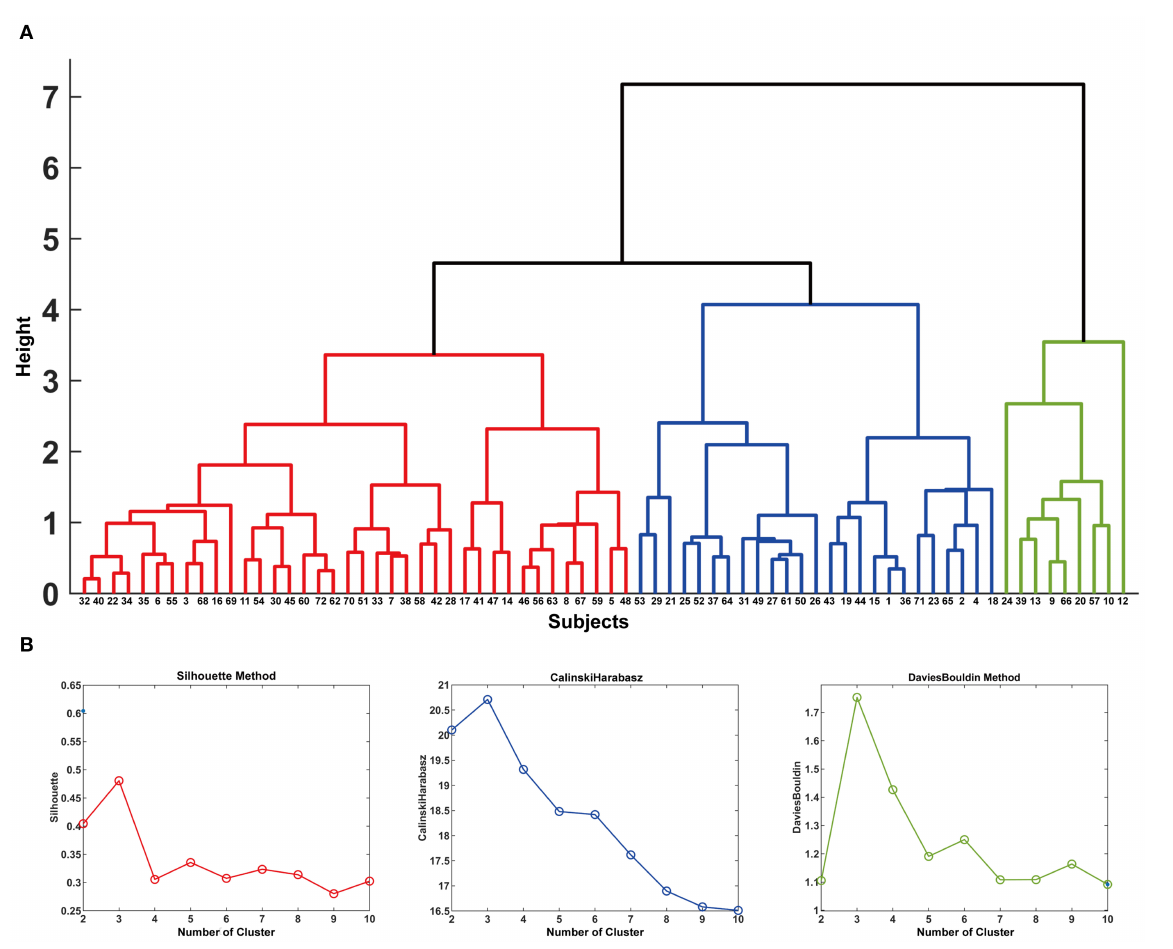
FIGURE4 In (A) , the dendrogram of the hierarchical clustering is illustrated. The y -axis shows the study-specific distances between the clusters as height h. When h = 0, each volume forms its own cluster, and h = 2 corresponds to splitting the volumes into 13 clusters. The x -axis shows the number for each subject. The results of Silhouette index, Calinski-Harabasz index and Davies-Bouldin index analyses are shown in (B)